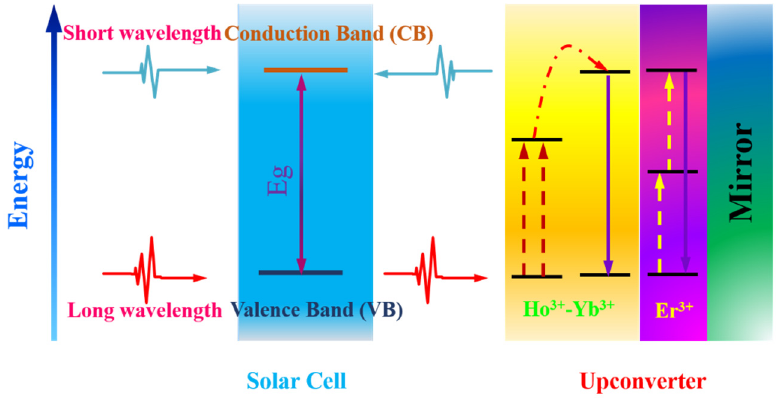
Figure 7. An operating mechanism for a c-Si solar cell with two upconverters, one co-doped with Ho 3+ –Yb 3+ and the other one single doped with Er 3+ . Photons with short wavelength can be absorbed directly by the solar cell. The transmitted sub-bandgap light can be upconverted into high-energy photons, which would be absorbed by c-Si. The mirror behind the upconverter increases the probability of absorption of sub-bandgap light in the upconverter layer.